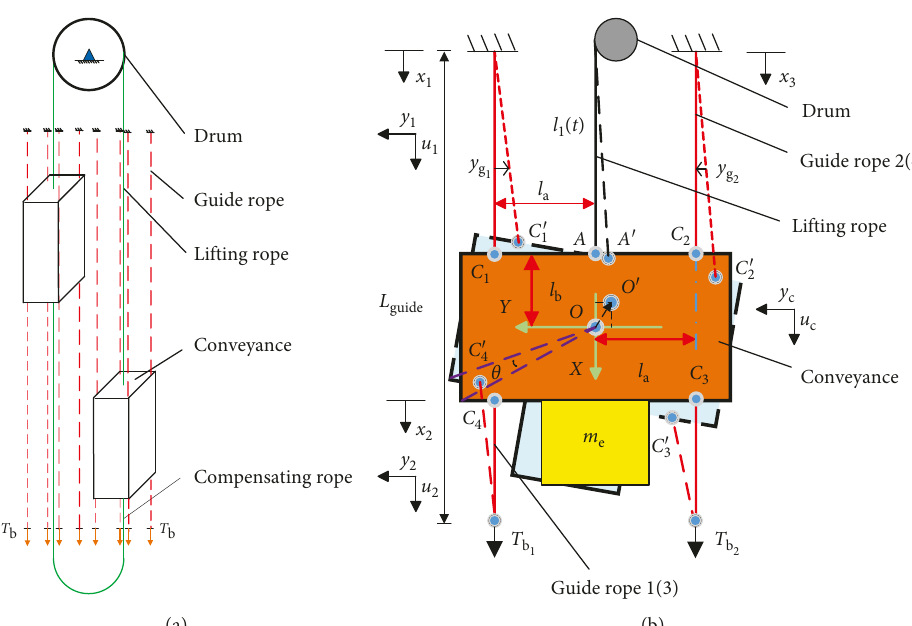
Figure 13: (a) Physical model and (b) mathematical model of a traditional traction